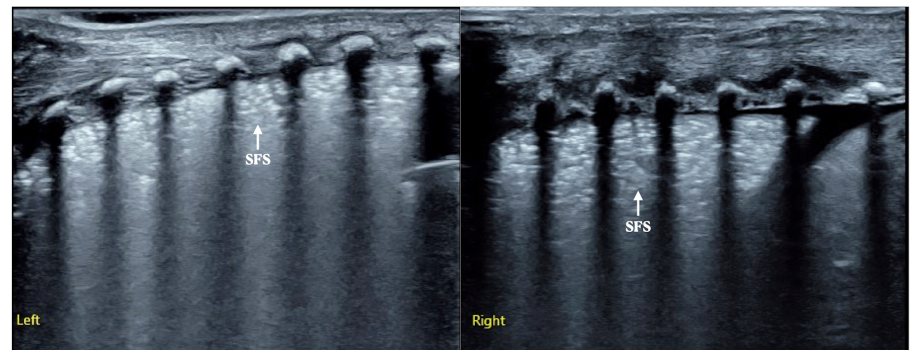
Figure 3. LUS findings of Case 2 infant. LUS presented as snowflake-like sign consolidation confirmed as RDS (Left: left lung, Right: right